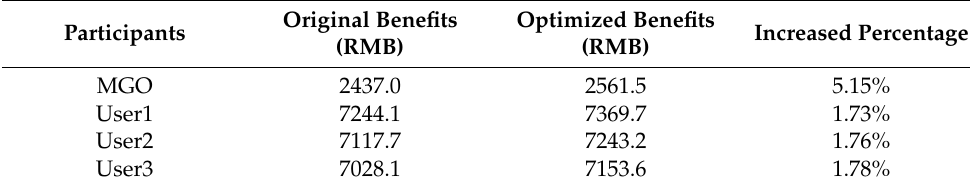
Table 2. Comparison of Economic